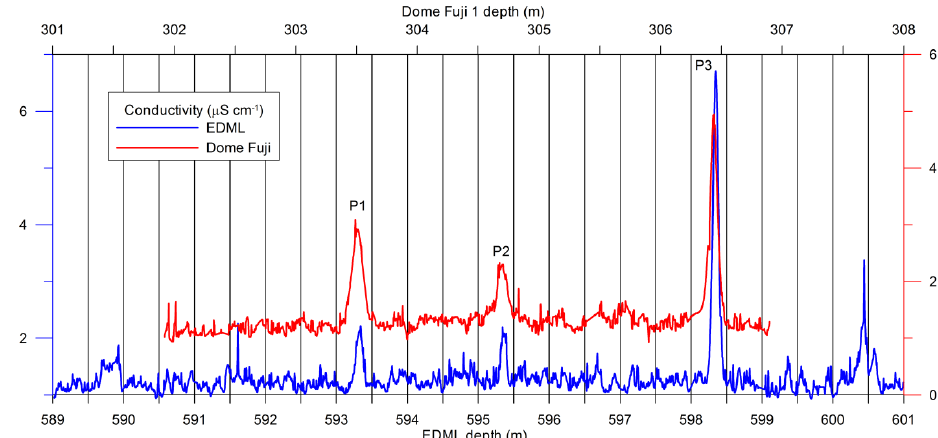
Figure 5. Volcanic matching of the Dome Fuji and EPICA Dronning Maud Land (EDML) ice cores based on the three characteristic acidity peaks P1, P2, and P3, here shown in the electrolytic conductivity signal. Due to the different shapes of the acidity peaks, the matching of the cores has an uncertainty of a few years.